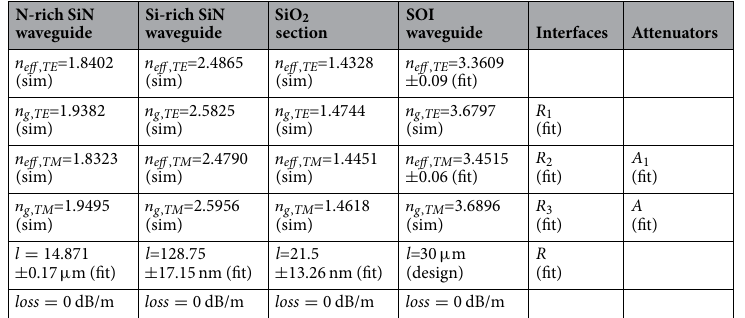
Table 2. Simulation parameters for the definition of the theoretical model of one block. The reflectivities R 1 , R 2 , R 3 , R of the interfaces and the attenuations A 1 , A are calculated through the fitting of the simulated and the measured